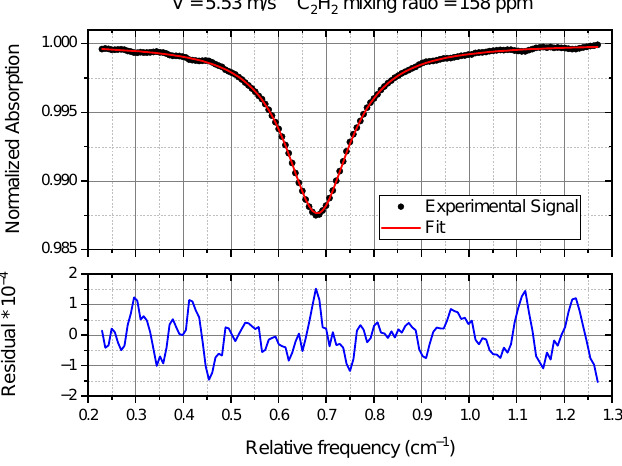
Figure 7. Plot of a direct absorption acquisition and its analysis.